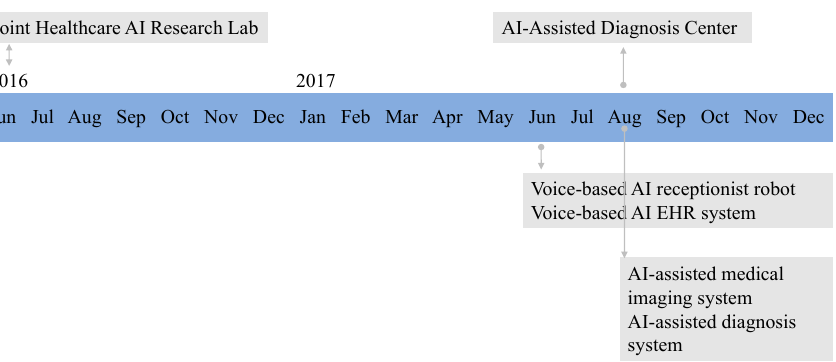
Figure 1. Timeline of the introduction of four artificial intelligence (AI)